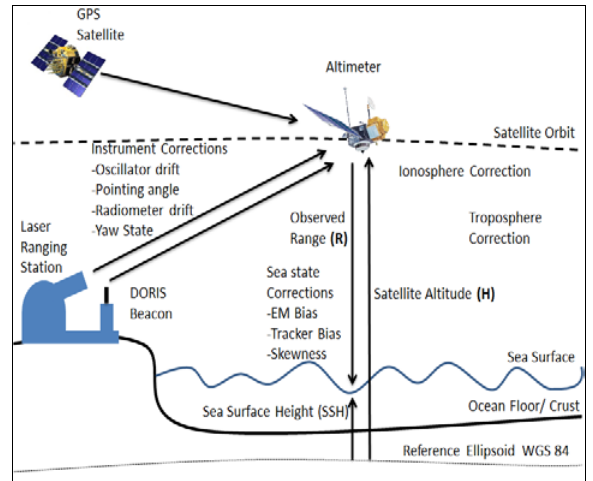
Figure 2. Schematic view of satellite altimeter measurement (modified after Watson, 2005; Din, 2014) Independent tracking systems are used to compute the satellite’s three-dimensional position relative to an earth-fixed coordinate system. Profiles of sea surface height, or sea level, with respect to a reference ellipsoid is obtained by combining these two measurements (Din, 2014). Sea level obtained or sea level anomaly (SLA) derived is used to compute the sea level